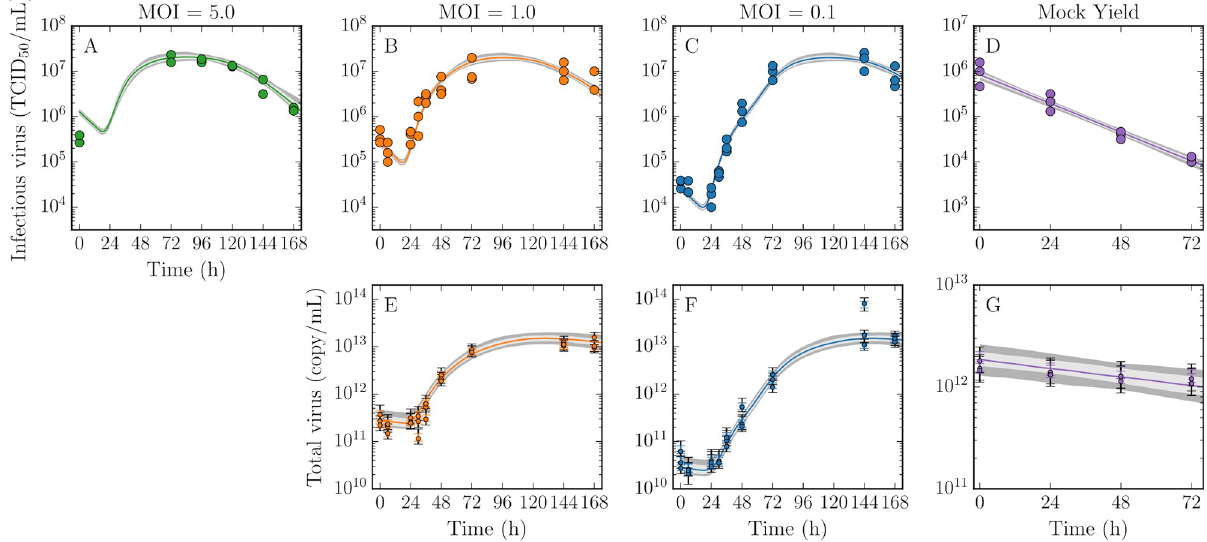
Fig 1. Kinetics of EBOV infection in vitro and mock yield assays. Vero cell monolayers were infected with EBOV at a multiplicity of infection (MOI) 5, 1, or 0.1 TCID 50 /cell, as indicated. At various times post-infection, the infectious (TCID 50 /mL; A–C) and total virus (copy/mL; E–G) in the supernatant were determined. A mock yield assay was also performed to quantify the decay of infectious (D) and total virus (G). In each assay, the experimental data (circles) were collected either in duplicate (MOI 5) or triplicate (all other assays). Note that the total virus concentration collected in the MOI 5 infection was omitted from the analysis due to inconsistencies in the peak value (S1 Appendix, Fig. A). The lines represent the pointwise median of the time courses simulated from our MM, which are bracketed by 68% (light grey) and 95% (dark grey) credible regions (CR). These data were used to extract the posterior probability likelihood distributions of the infection parameters (Fig 2). Note that parameters of the calibration curve used to convert cycle threshold values (Ct) to total virus (copy/mL) were also estimated (Fig 3). The variability introduced from this conversion is shown by two error bars on each total virus data point, indicating the 68% (same colour) and 95% (black) CR.